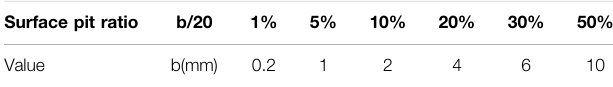
TABLE 1 | Various parameters were used to model the fl ow past the square cylinder. Surface pit ratio